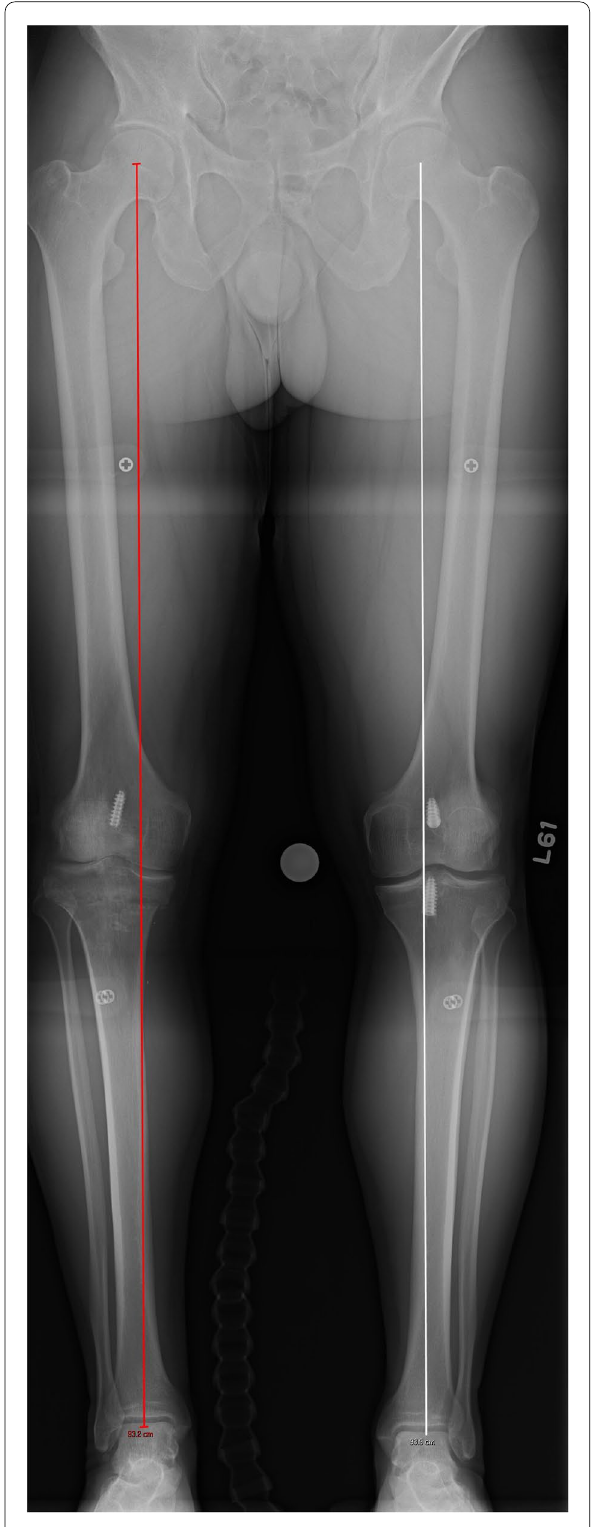
Fig. 9 A post-operative standing mechanical axis radiograph demonstrating varus collapse of the anterior closing wedge